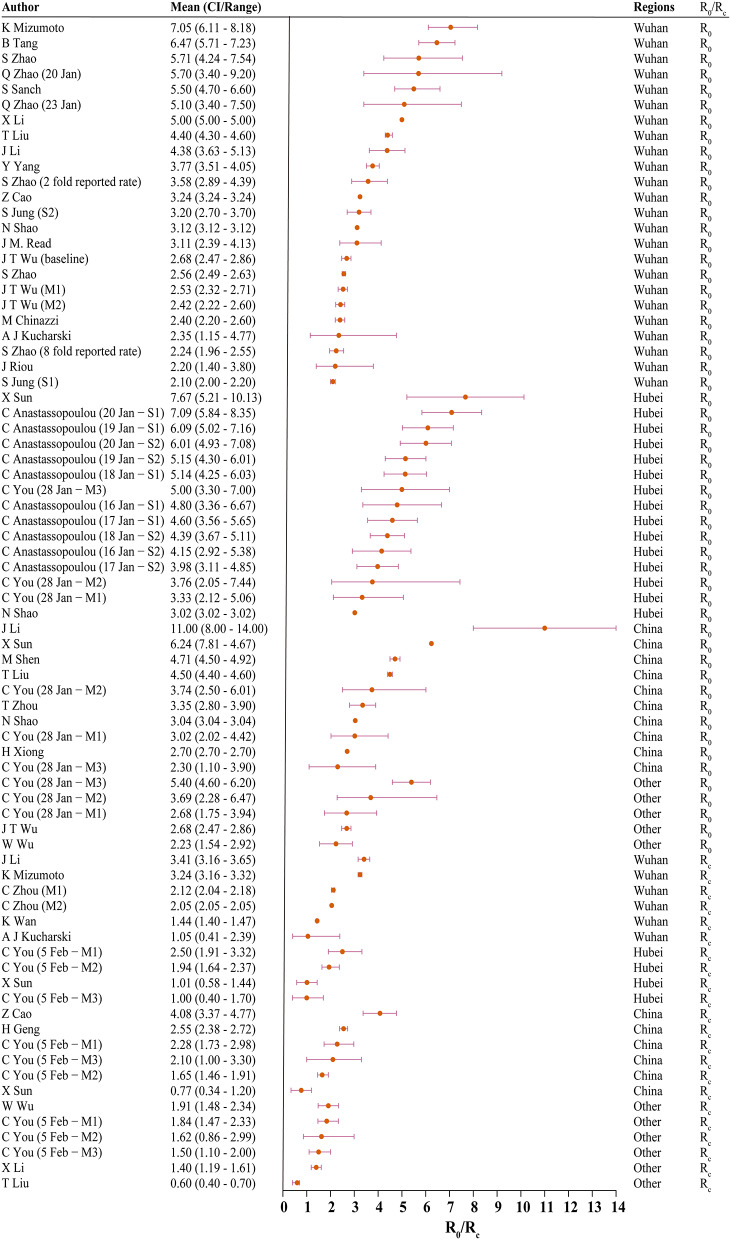
The basic reproduction number (R0) and controlled reproduction number (Rc) estimated among models. CI, confidence interval; M1, model 1; M2, model 2; S1, scenario 1; S2, scenario 2; Other, regions other than Hubei in China.